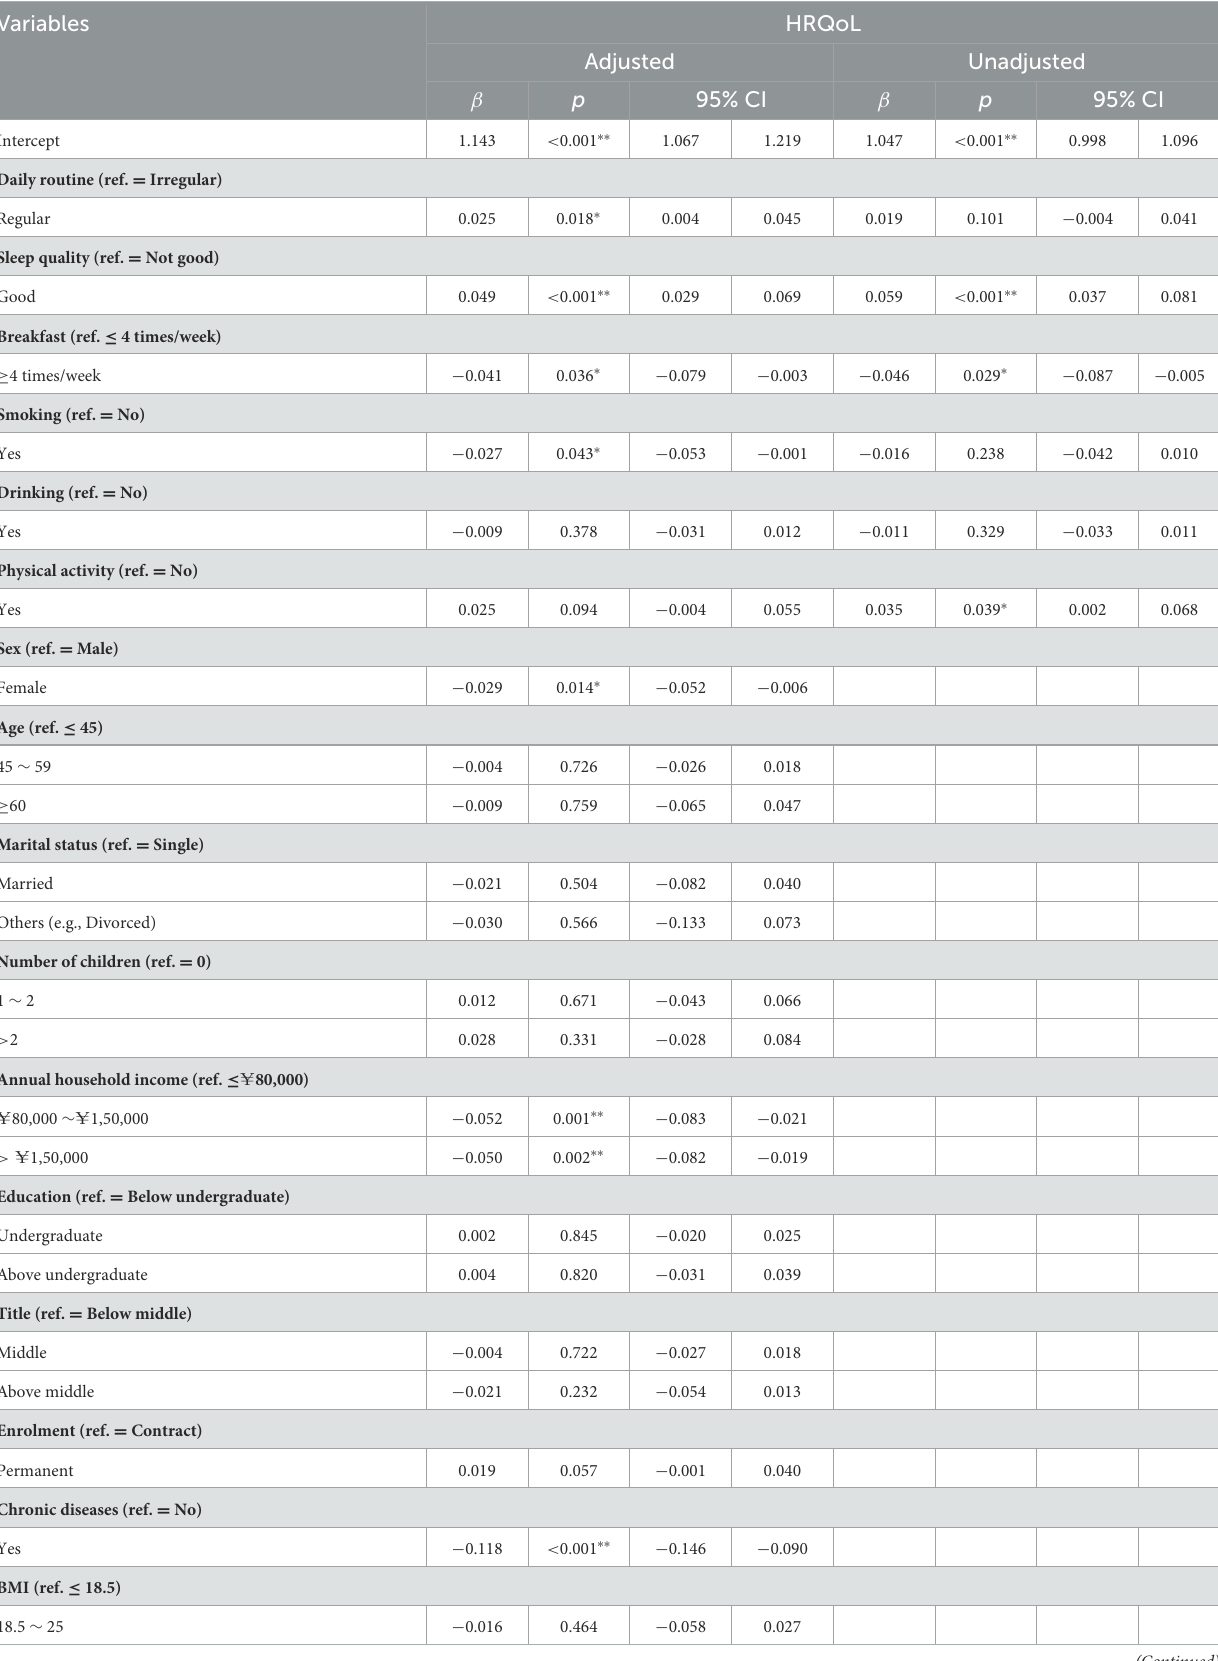
TABLE 2 Tobit regression analysis between sociodemographic characteristics, lifestyle behaviors and HRQoL.